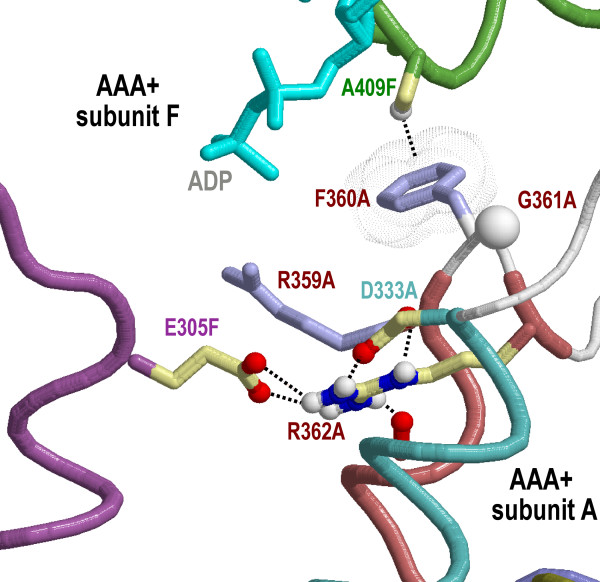
Structural location of the two-residue insert in Box VII of p97. The structure of the first domain (D1) of p97 from rat [34] is shown. The corresponding alignment is shown in Fig. 6.